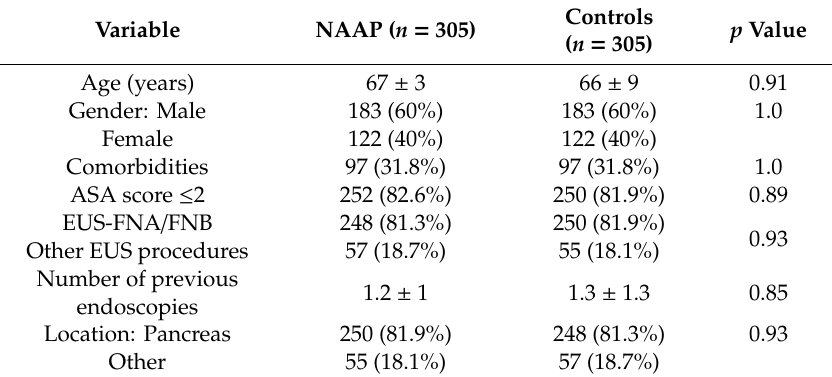
Table 2. Baseline patients’ characteristics after propensity score